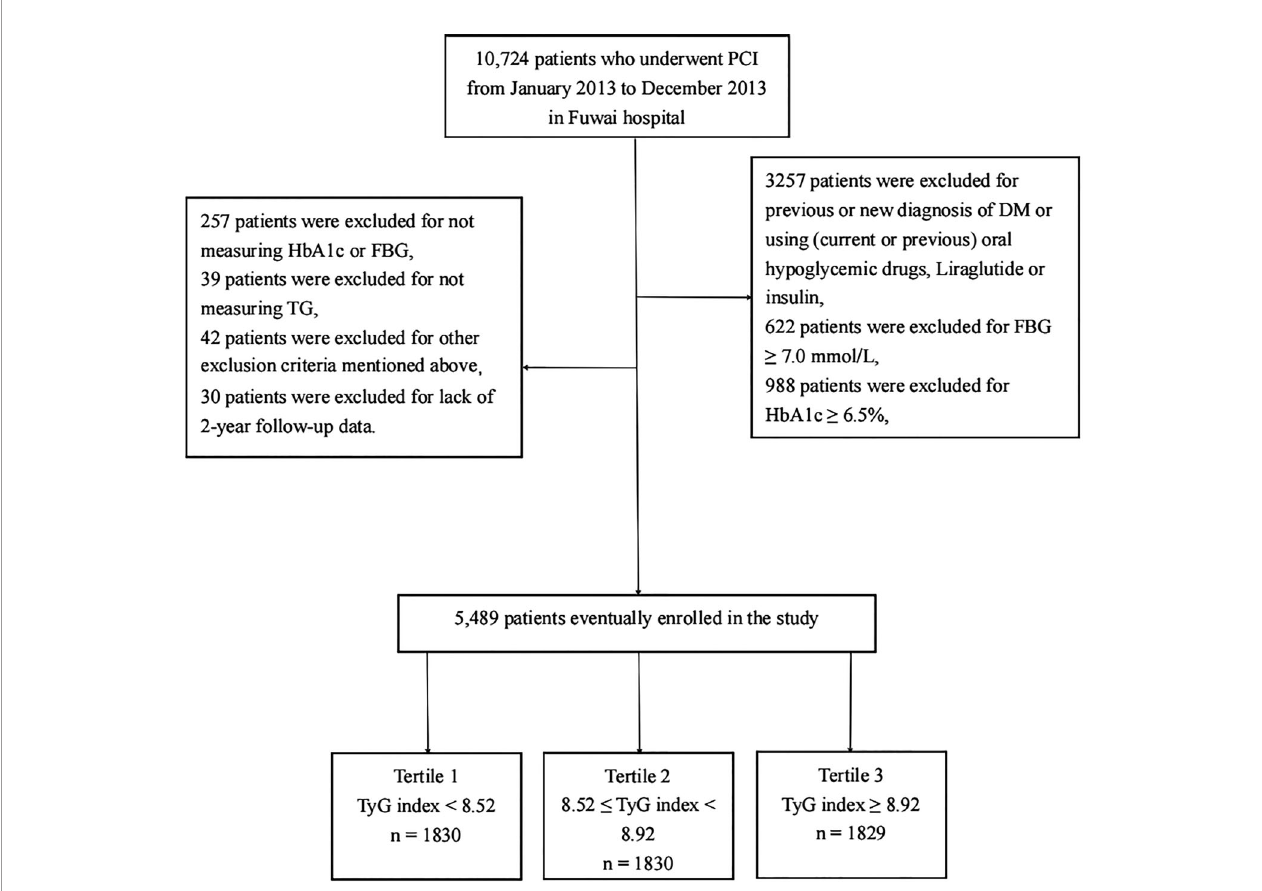
FIGURE 1 | Flowchart of the study population enrollment. PCI, percuntaneous coronary intervention; DM, diabetes mellitus; FBG, fasting blood glucose; HbA1c, Hemoglobin A1c; TG, triglycerides, TyG index, triglyceride-glucose